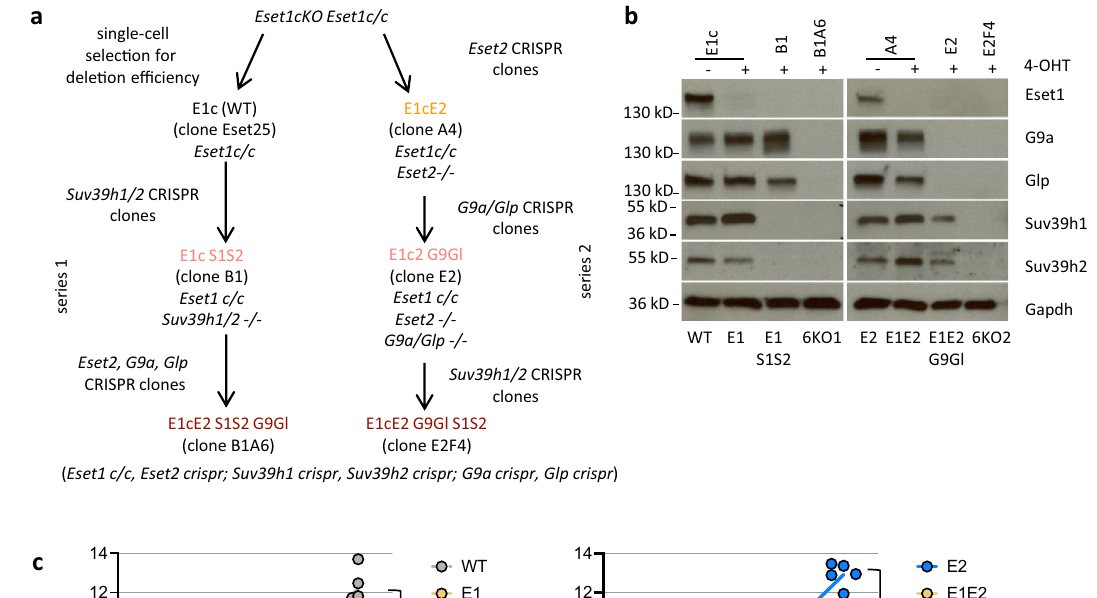
(Fig. 2e). Consistent with our previous observations with H3K9 SET-domain gene pair mutants, Eset1 ( E1 ), Eset2 ( E2 ), and Eset1/ Eset2 ( E1E2 )-de fi cient cells display comparable levels of H3K9 methylation as WT cells. Compound Eset1 and Suv39h1/Suv39h2 mutants ( E1 S1S2 ) largely lack H3K9me3, while compound Eset1 / Eset2 and G9a / Glp mutants ( E1E2 G9Gl ) have drastically reduced H3K9me1 and H3K9me2. Strikingly, in extracts from the